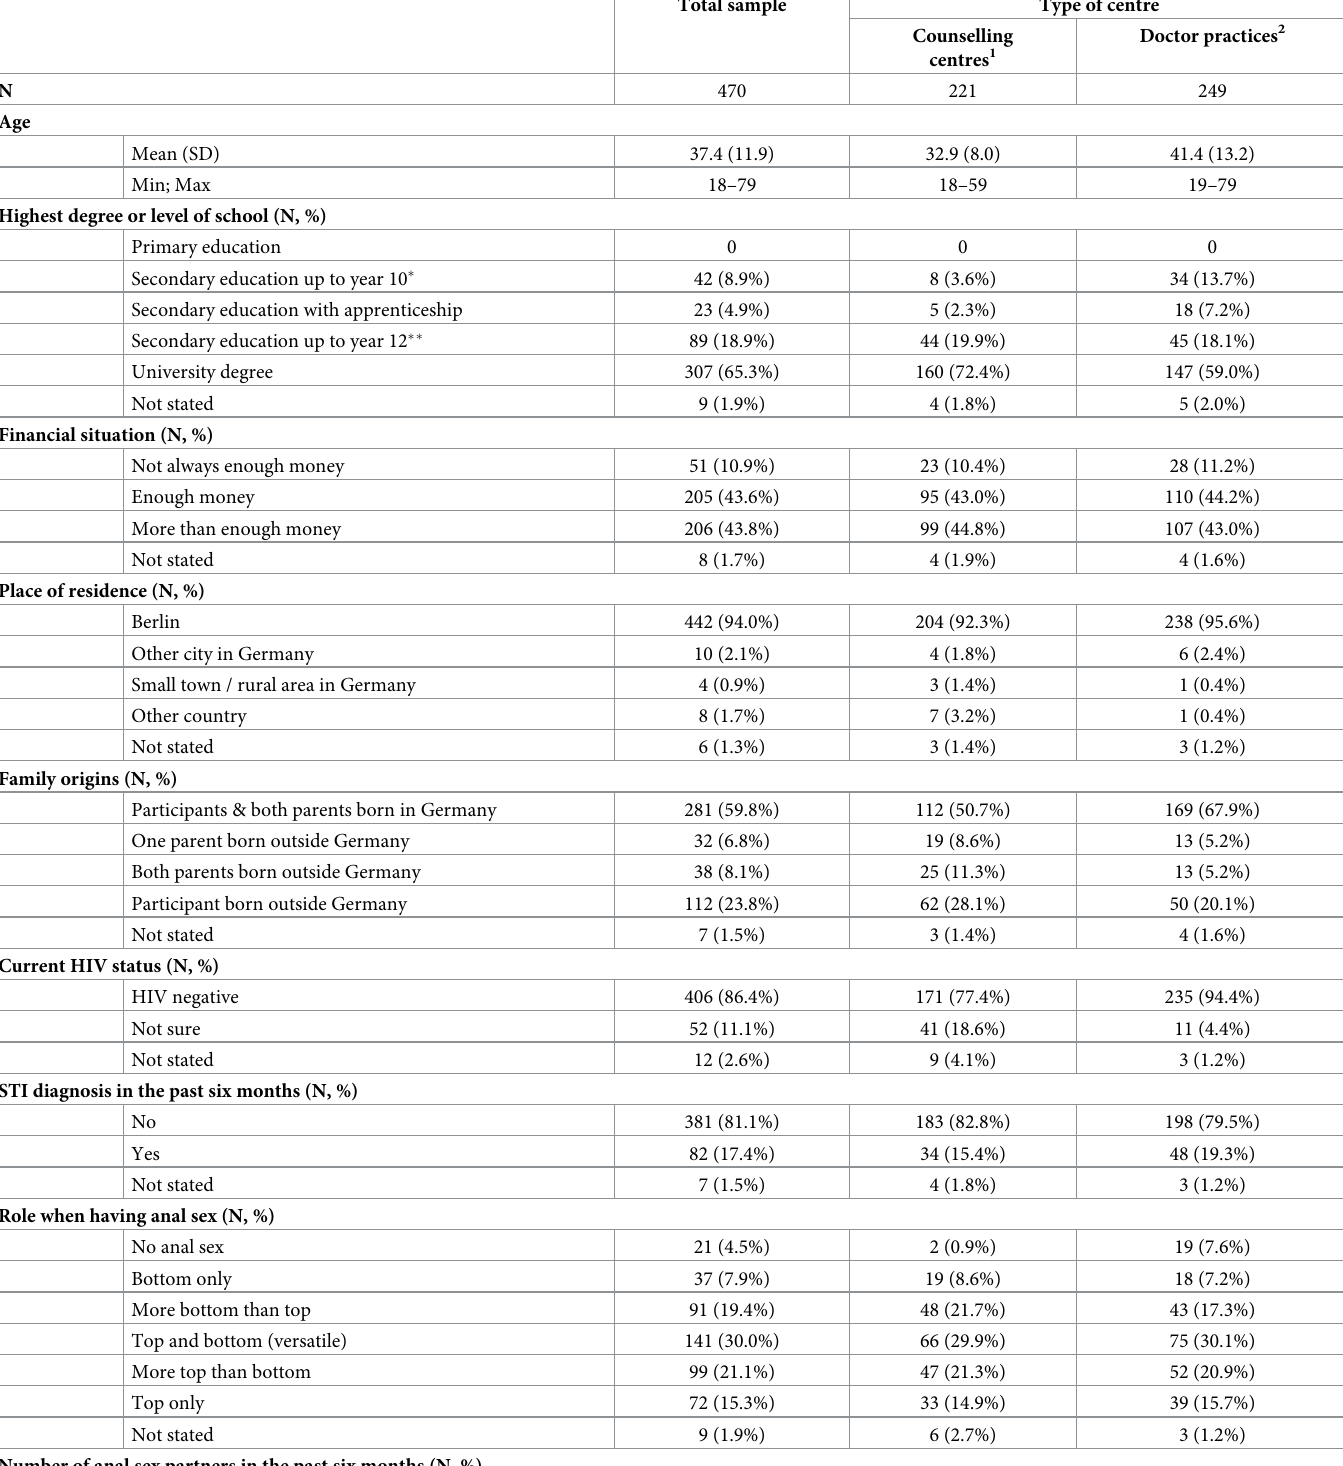
Table 2. Demographic data and sexual risk behaviour; total sample and subsamples according to type of